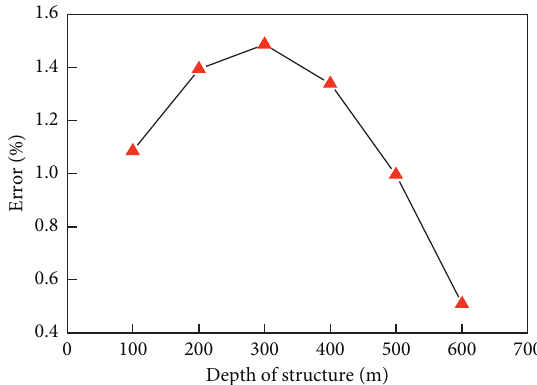
Figure 23: Relationship between the error and burial